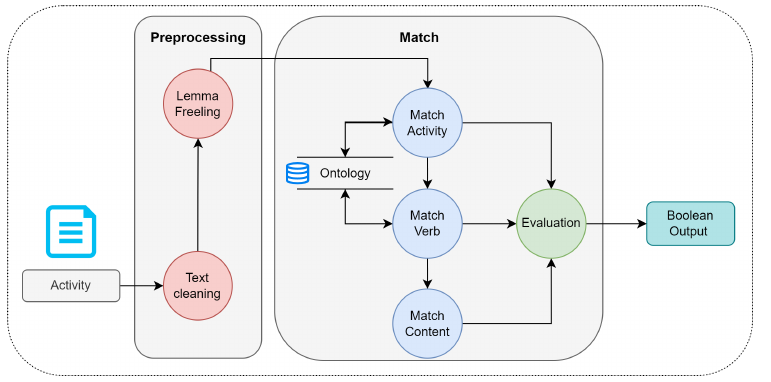
Figure 7. Match process